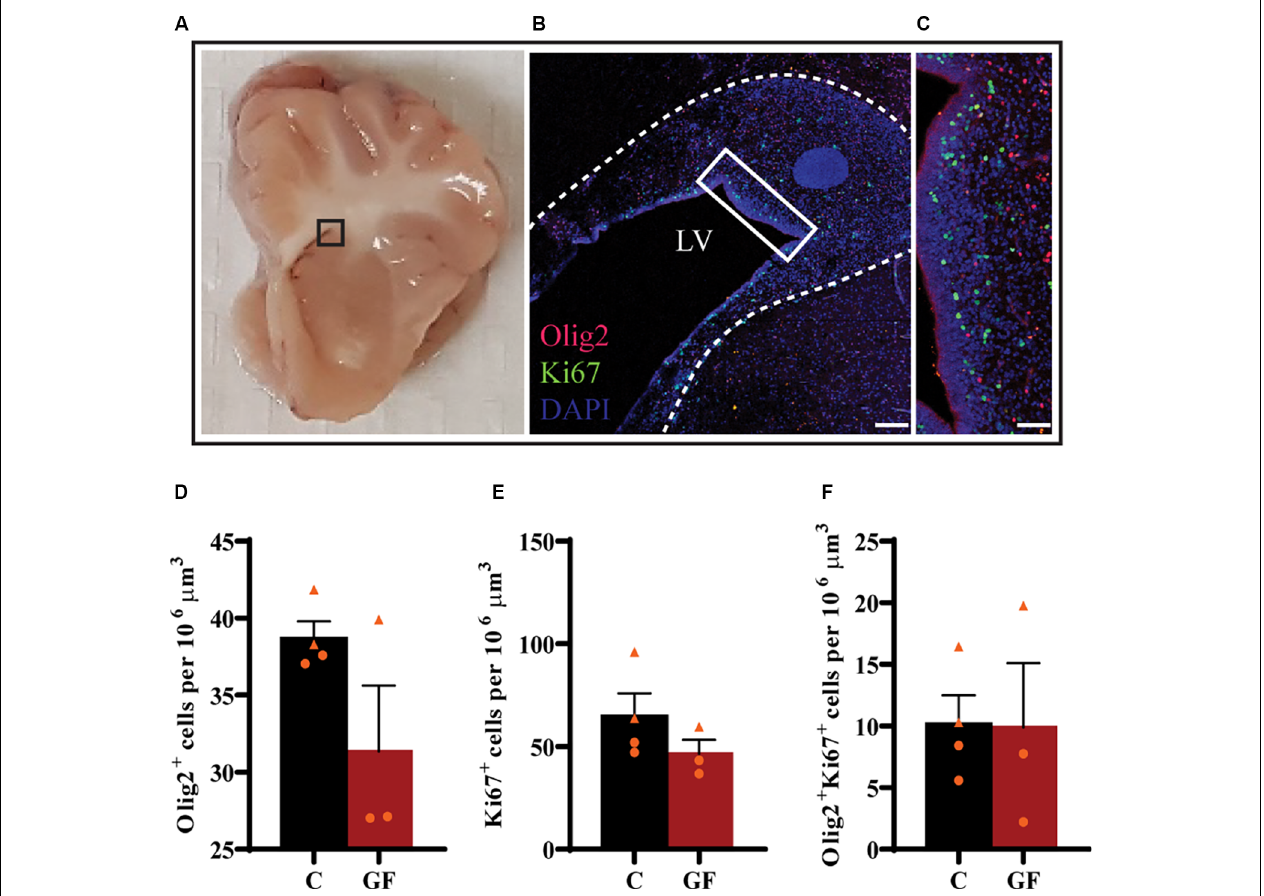
FIGURE 5 | No effects of germ-free conditions on oligodendrogenesis within the subventricular zone at P16. (A) Gross anatomical map to demarcate region of interest (B) . (B) Low magnification image of the SVZ, immunolabeled with Olig2 and Ki67, corresponding to inset (in A ). (C) Higher magnification image of inset (in B ). Quantification of the number of oligodendrocytes (D) , proliferating cells (E) , and proliferating oligodendrocytes (F) . LV, lateral ventricle; C, control; GF, germ-free. Data not significant by unpaired student’s t test. Data expressed as mean ± SEM, n = 3–4